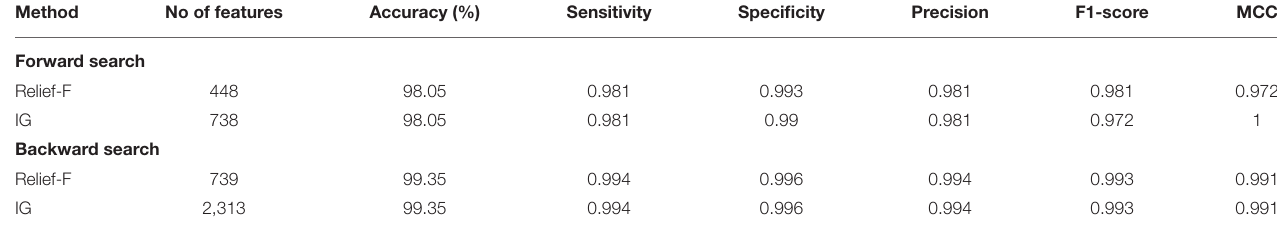
TABLE 6 | Binary classification accuracy (%), number of features, and other performance metrics before and after feature selection for the feature set 5 selected using forward and backward strategies. Method